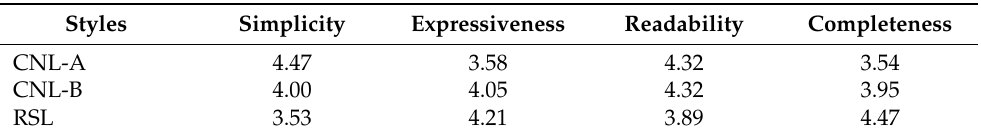
Table 5. How do participants rate CNL-A, CNL-B, and RSL according to the following concerns (values in a 1–5 scale)?